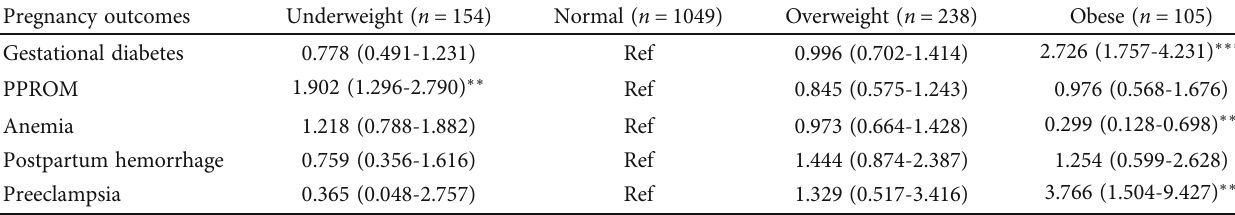
Table 4: E ff ects of prepregnancy BMI on pregnancy outcomes.